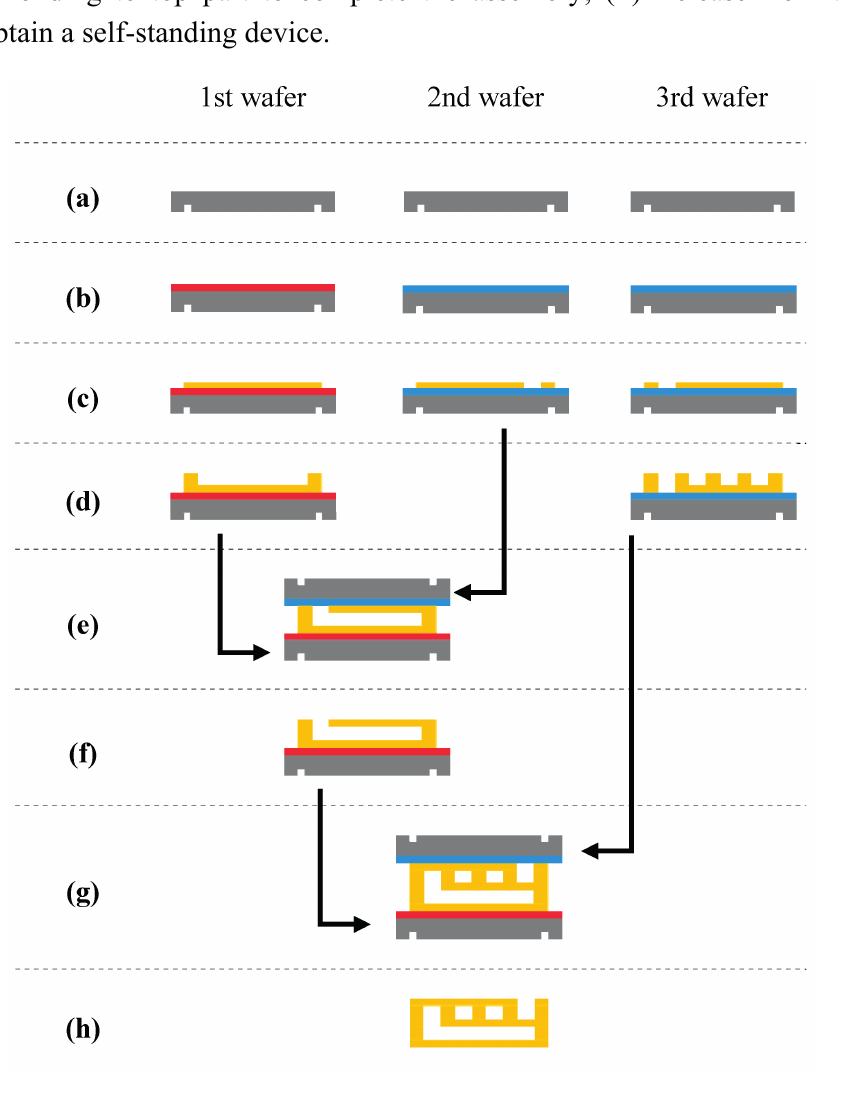
Figure 5. Process flow for the fabrication of thin double layer SU-8 microfluidic